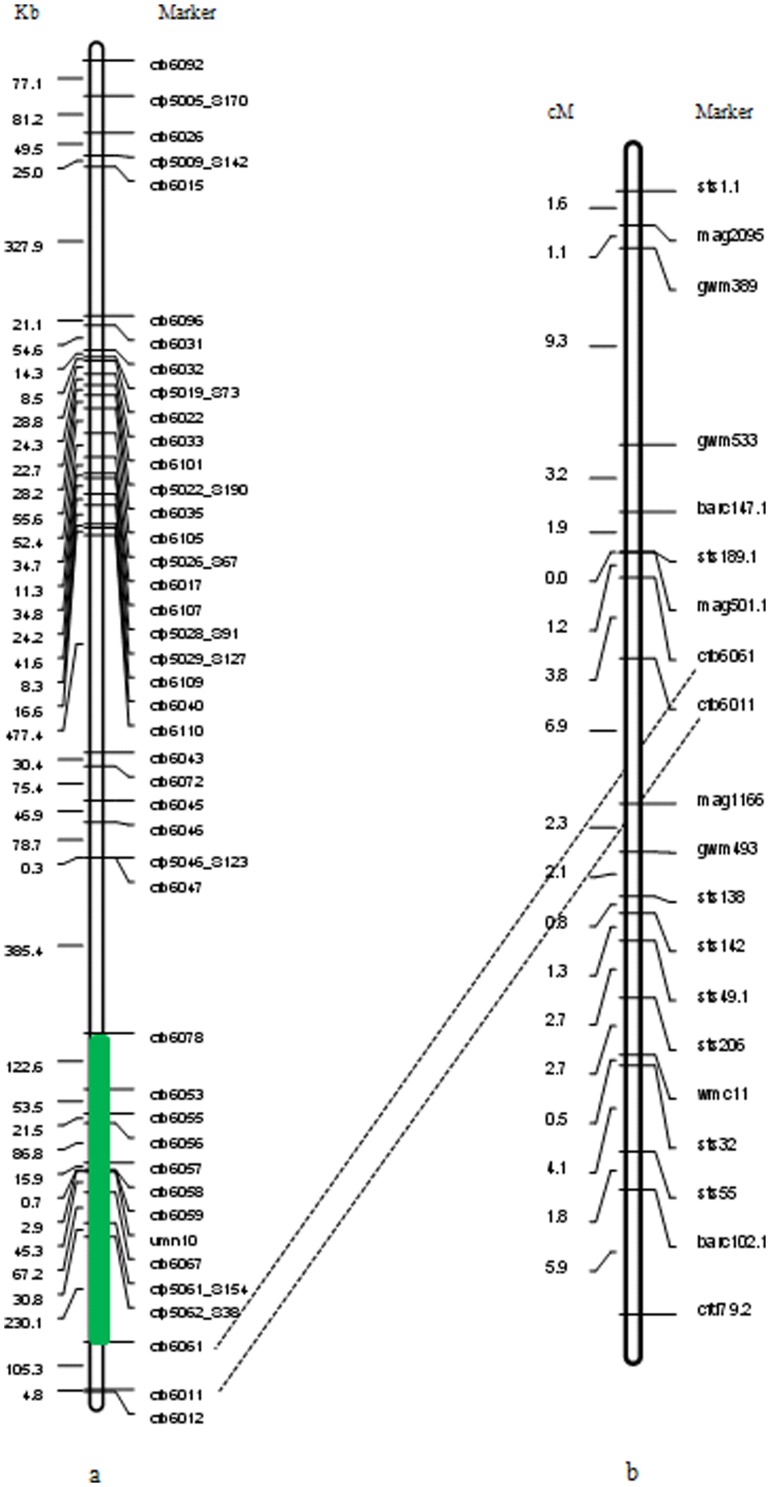
Fine mapping of SSR loci analyzed in the present study.(a) Physical map of molecular markers from sequencing the contig ctg954 constructed using Chinese Spring. Dashed lines join the same loci on both maps, and the green box in the physical map indicates the region that might include the Fhb1 (B. Gill pers. comm.). The umn10 was developed by Liu et al. (2008) [26] as a marker widely used for MAS in FHB-resistance breeding. (b) Genetic map localizing cfb6061 and cfb6011 based on a recombinant inbred line (RIL) population (Nanda 2419×Wangshuibai).